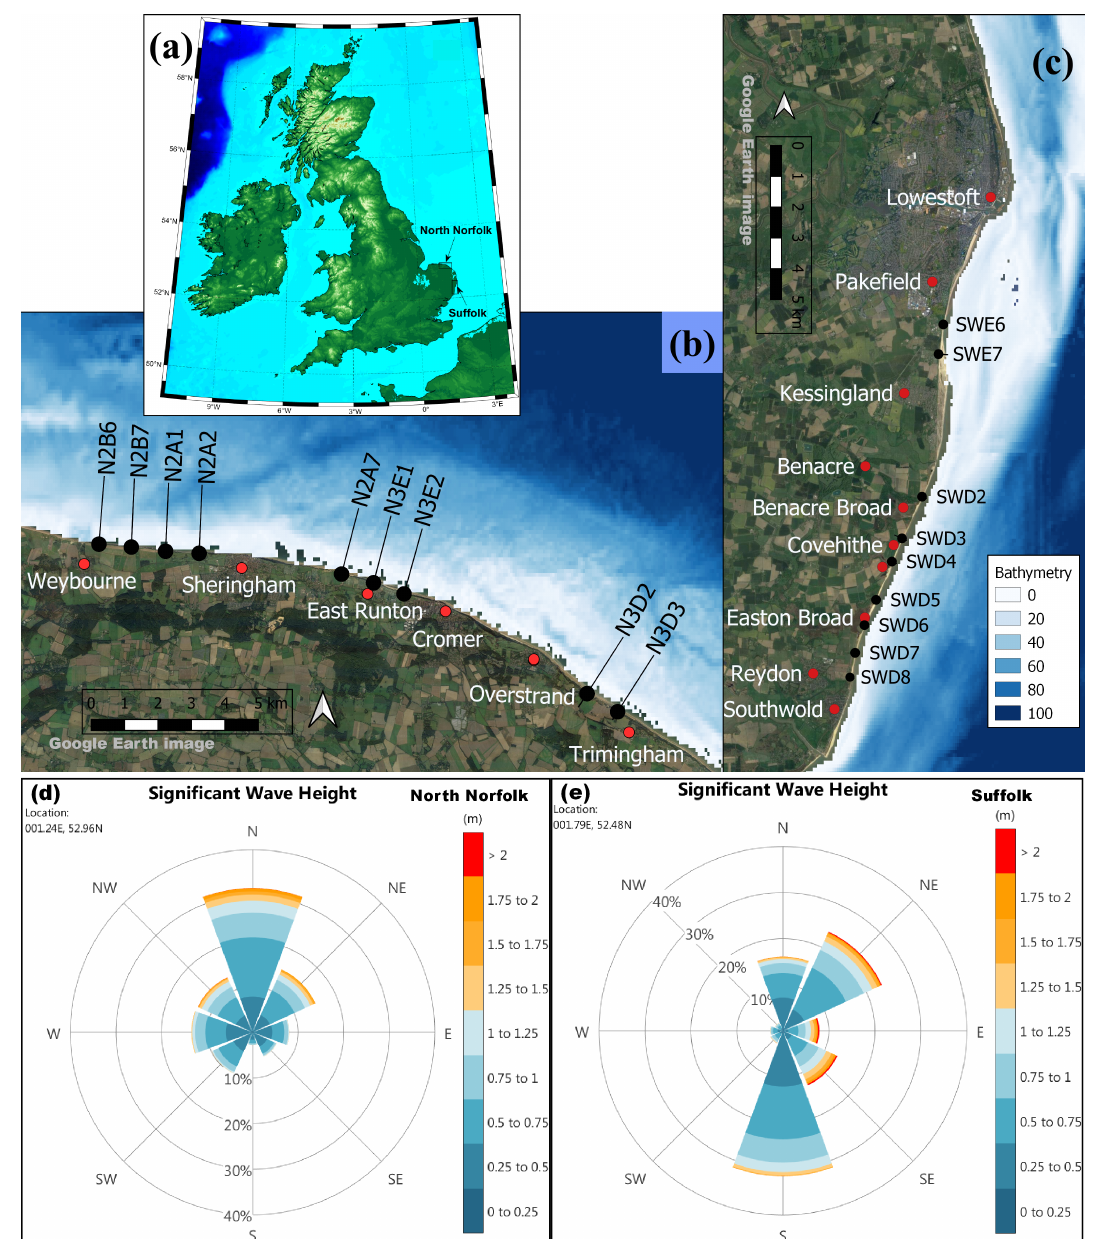
Figure 1. ( a ) General location of cliff lines. ( b ) North Norfolk cliffs and profile locations. ( c ) Suffolk cliffs and profile locations. Wave rose for North Norfolk ( d ) and Suffolk ( e ) areas